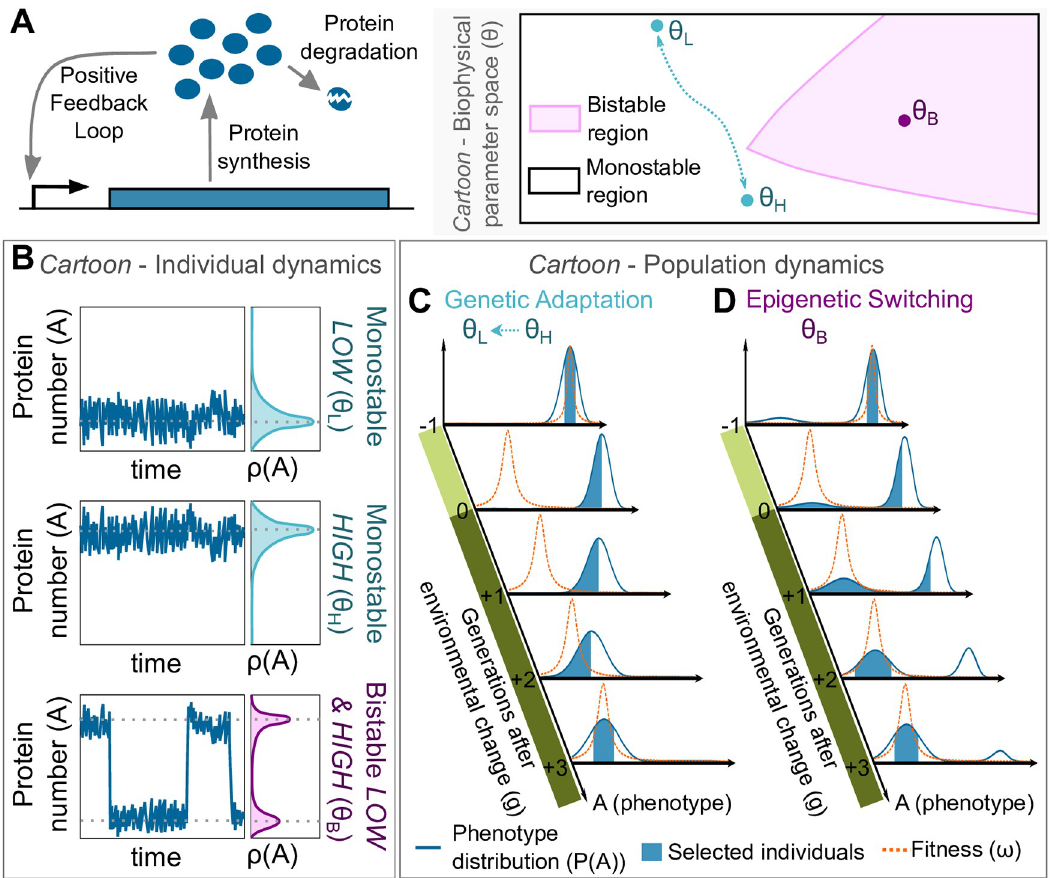
Fig 1. Genetic adaptation and epigenetic switching of a self-activating gene. (A) Diagram of a self-activating gene that considers two biochemical events: protein synthesis with a rate that increases with number of proteins A (i.e. positive feedback loop) and protein degradation. On the right, a cartoon of the biophysical parameter space or genotypes ( θ ) of this gene circuit with two characteristic regions: monostable (white) and bistable (pink) phenotypes. In the monostable region, a genotype ( θ or θ ) might be L H optimal in either one environment (e.g. LOW protein numbers) or the other (e.g. HIGH protein numbers). Genetic mutations are required to change from one solution the other (blue arrow). In the bistable region, a single genotype ( θ ) can display two different B phenotypes with each phenotype potentially optimal in both environments. (B) Cartoon of the protein number ( A ) dynamics in an individual cell with each of the genotypes described in (A). Monostable genotypes ( θ L and θ H ) exhibit a unimodal distribution of ) exhibits a bimodal distribution having spontaneous transitions between protein expression ( ρ ( A )), whereas a bistable genotype ( θ B phenotypic states over time (i.e. epimutations) triggered by stochastic gene expression. Cartoon of the population dynamics using (C) genetic adaptation or (D) epigenetic switching to adapt after an environmental change. The fitness score function ( ω ; orange dashed line) and the phenotype distribution of the population ( P ( A ); blue line) are shown for each generation ( g ), and the fraction of the population expected to be selected in the next generation (i.e. individuals with higher fitness scores) are highlighted (blue area). The environment changes from selecting HIGH protein numbers (light green) to select LOW protein numbers (dark green).